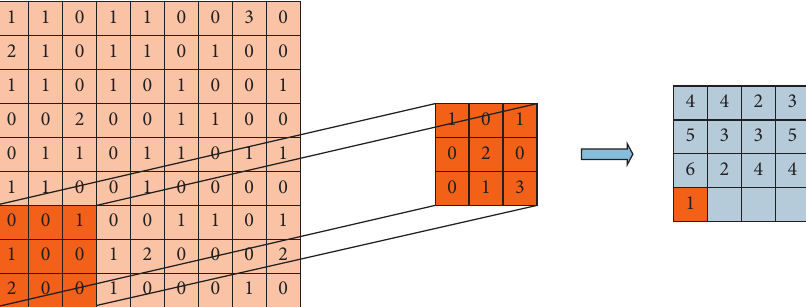
Figure 5: Convolution diagram (3 × 3) (step 2).